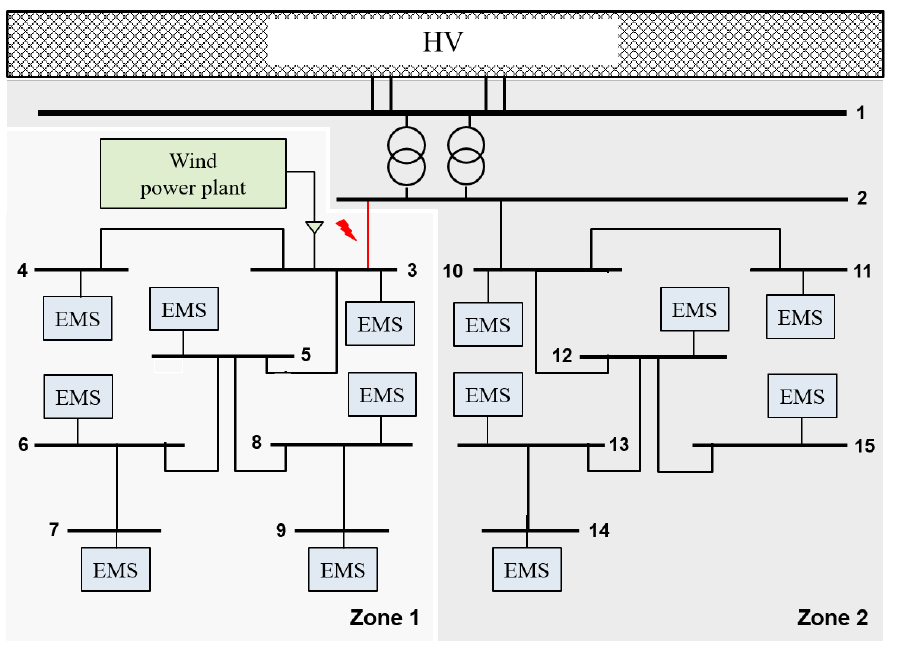
Figure 12. Grid structure of case study.